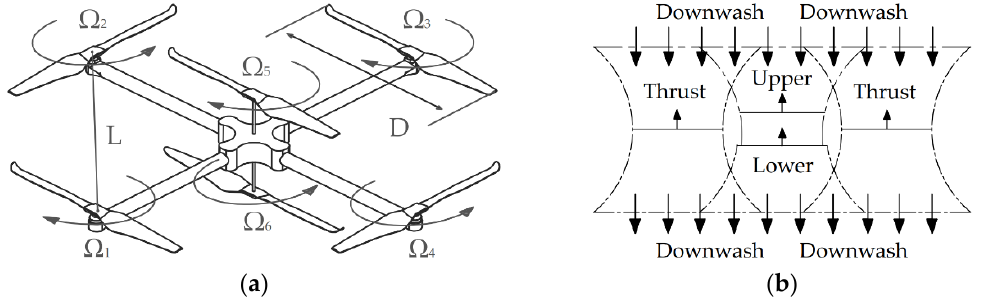
Figure 1. Sketch of the coaxial hex-rotor MAV. ( a ) Vehicle Structure; ( b ) flowfield model. There are three primary forms of aerodynamic interference in the hex-rotor MAV (1) interference between adjacent single rotors. The hover performance for the quad-rotor system is mainly affected by the behaviors of wakes. (2) Interference between the upper rotor and lower rotor of the coaxial rotor. The swinging blades and wandering vortexes make the aerodynamic optimization for coaxial rotors a real challenge. The lower rotor usually suffers a higher aerodynamic degradation by the influence of the upper rotor wake. (3) Interference between the single rotor and the coaxial rotor. Clearly, for the co- axial rotors, the downwash of the upper rotor imposed on the bottom rotor will defi- nitely decrease the whole efficiency for certain spacing where the coaxial rotors is still domain the whole flowfield. Additionally, the downwash velocity and induced velocity are considered to be equivalent in hover, it may cause vibration, which is also a disad- vantage for the MAV as a